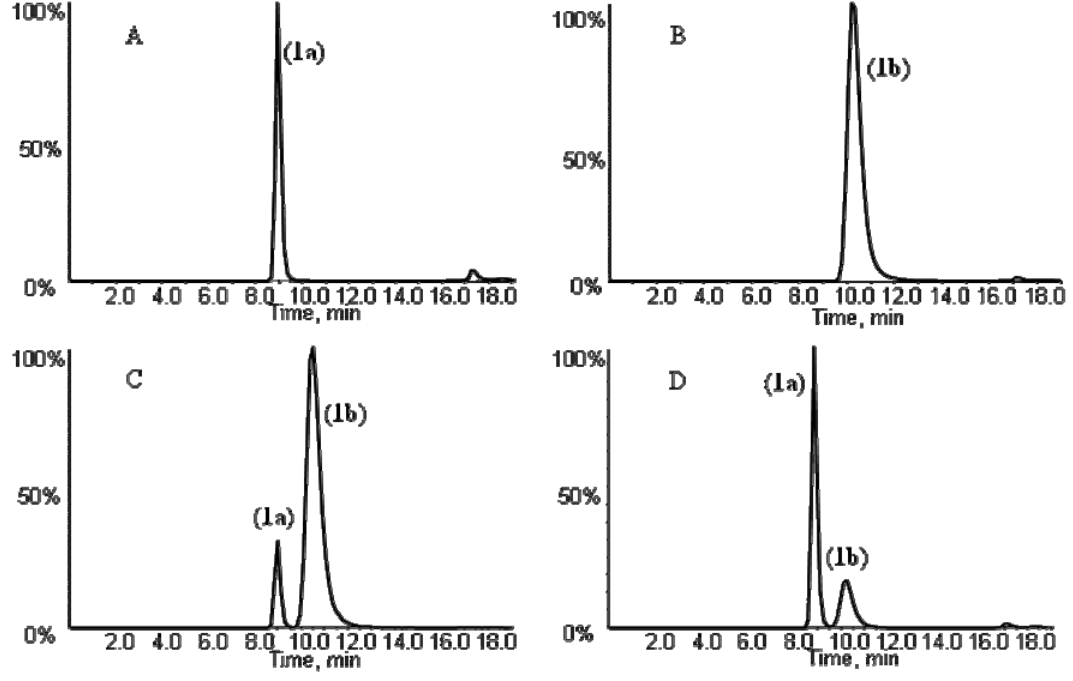
Figure 4. Typical extracted ion current chromatograms (XIC) (263.1 > 203.1) of authentic 1a (A) and 1b (B), and samples from incubations of compound 5 (C) and 6 (D) with rat liver microsomes under chiral LC-MS/MS analytical